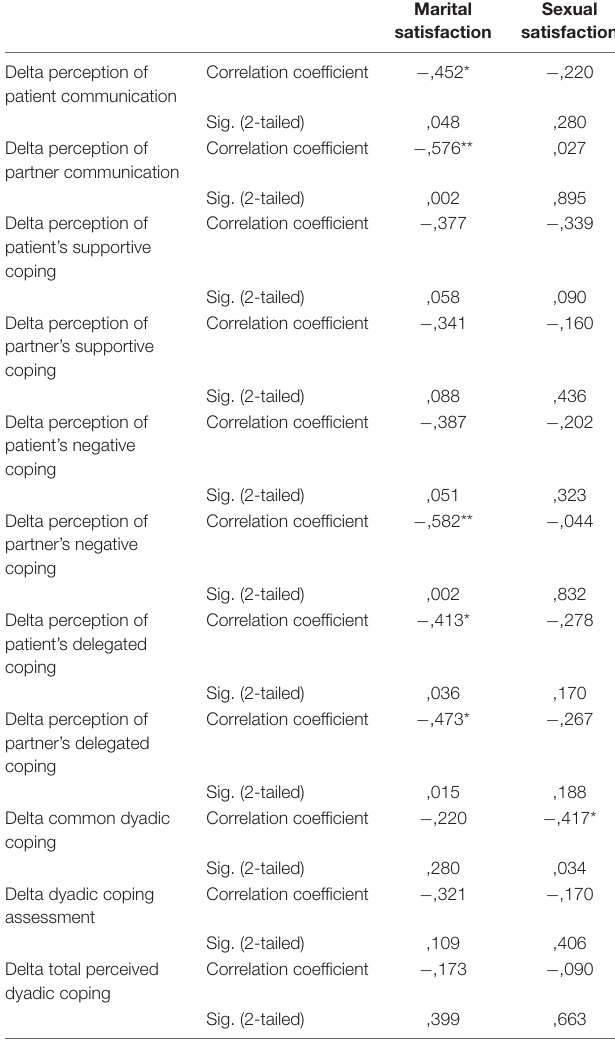
TABLE 6 | Correlation between delta of dyadic coping strategies and adjustment